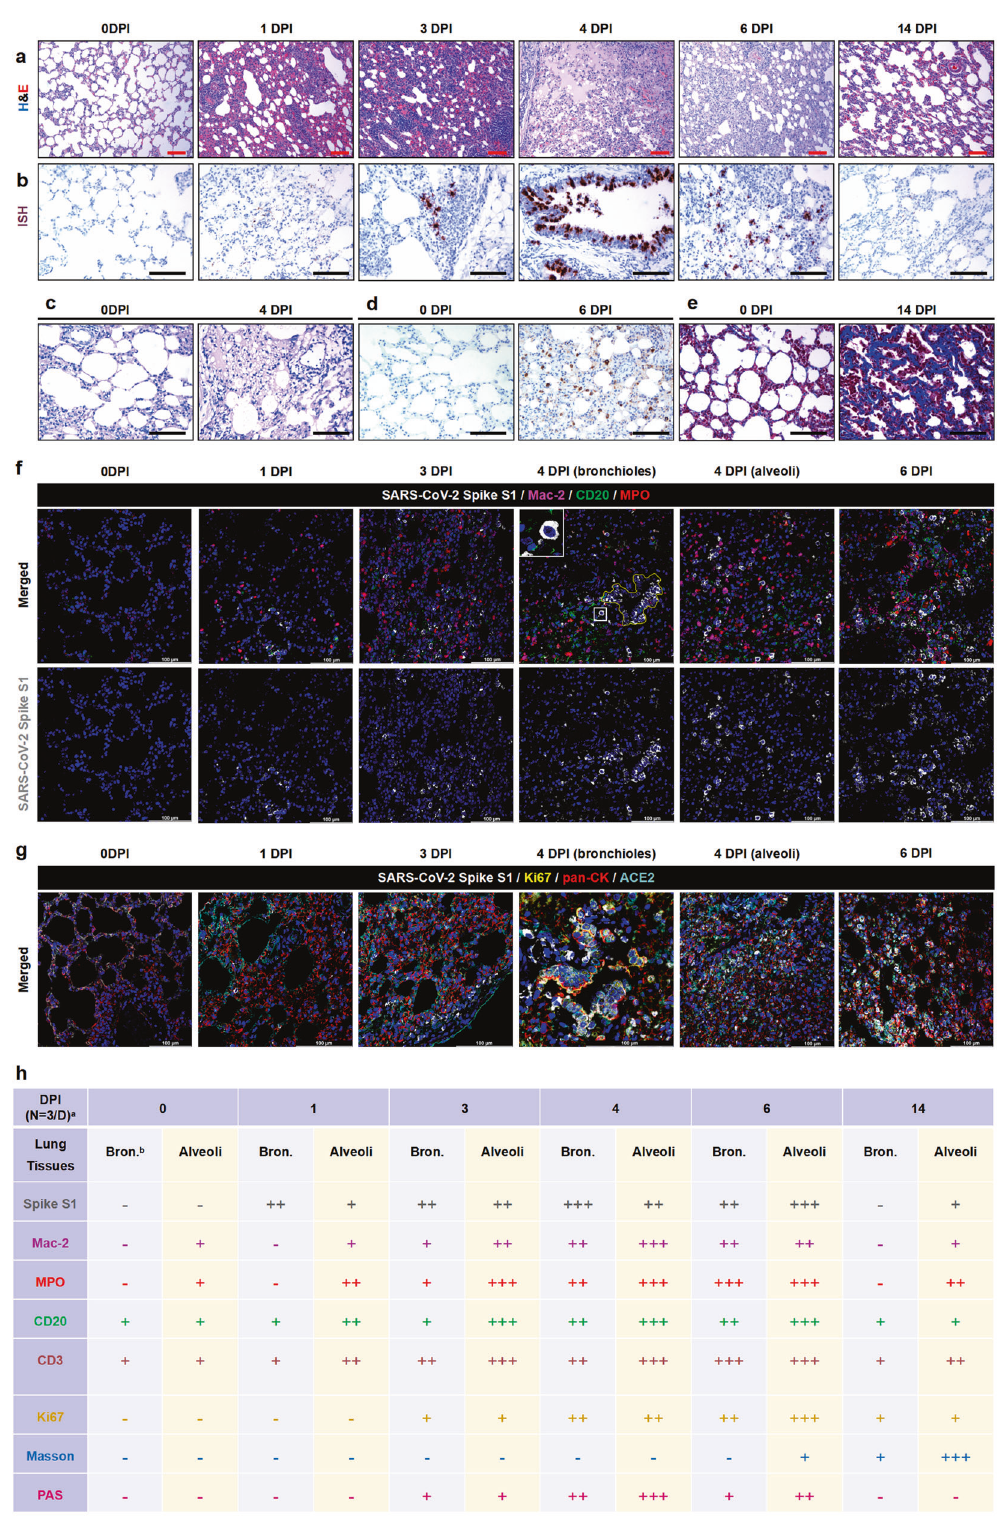
the pathophysiologic characterization of SARS-CoV-2-induced systemic disease in minks but also provides a potential opportunity to develop the mink as an effective animal model of SARS-CoV-2 infection to explore prevention and treatment. Signal Transduction and Targeted Therapy (2022)